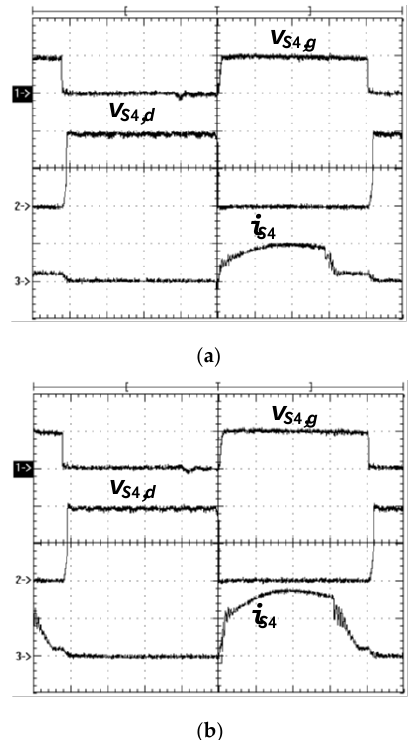
Figure 13. Measured waveforms of the lagging-leg switch S 4 at 800 V input ( a ) 50% load and ( b ) full load (v S4,g : 10 V / div; v S4,d : 200 V / div; i S4 : 2 A / div; time: 2 µ s / div).